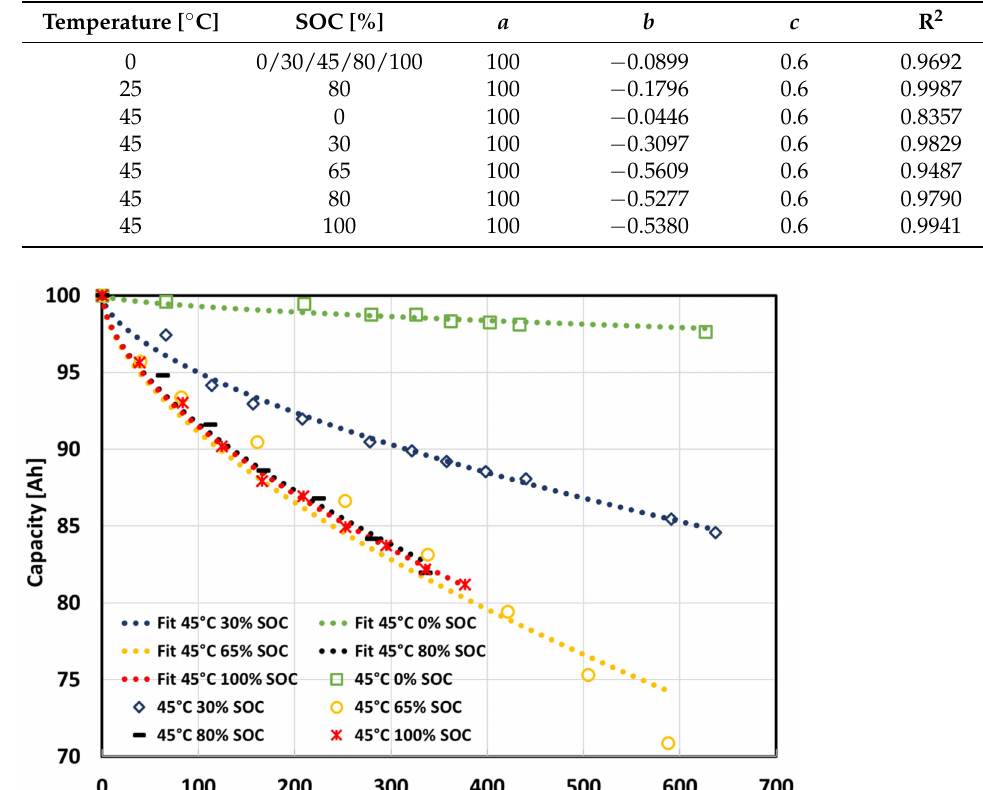
Table 11. R-square fitting curve (3).